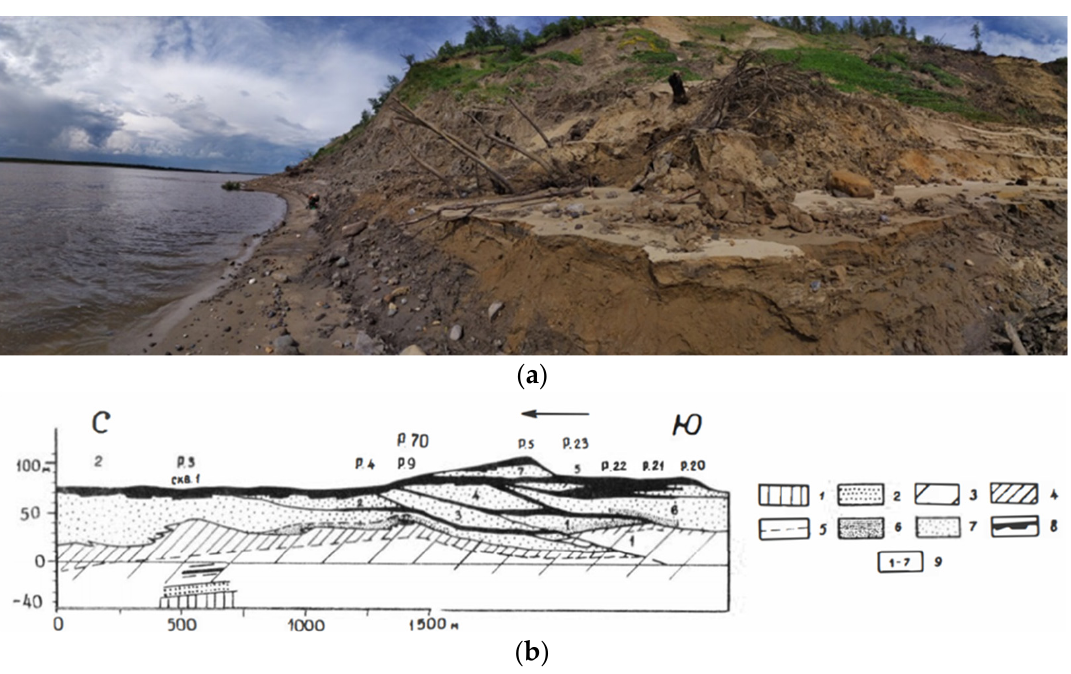
Figure 3. The structure of the outcrop Vastyansky Kon’ reproduced with permission from [3]. ( a ) photo of the Vastyansky Kon’ outcrop and the place where whole shells of mollusks were collected near the level of the river Pechora in gray clays (white arrow). ( b ) geological structure of the outcrop Vastyansky Kon’: 1: pre-Quaternary rocks; 2: pebble sands at the base of Quaternary deposits; 3–5: thickness of gray clays; 3: lower pack, 4: top pack, 5: marking layer, shell rock; 6–7: a pack of sands: 6: with sea shells, 7: continental; 8: layer of gravel-pebble loam with boulders, 9: numbers of blocks of the allochthonous thrust limb.